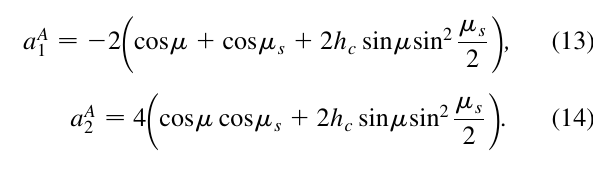
TABLE I. Parameters for the stop band examples. The